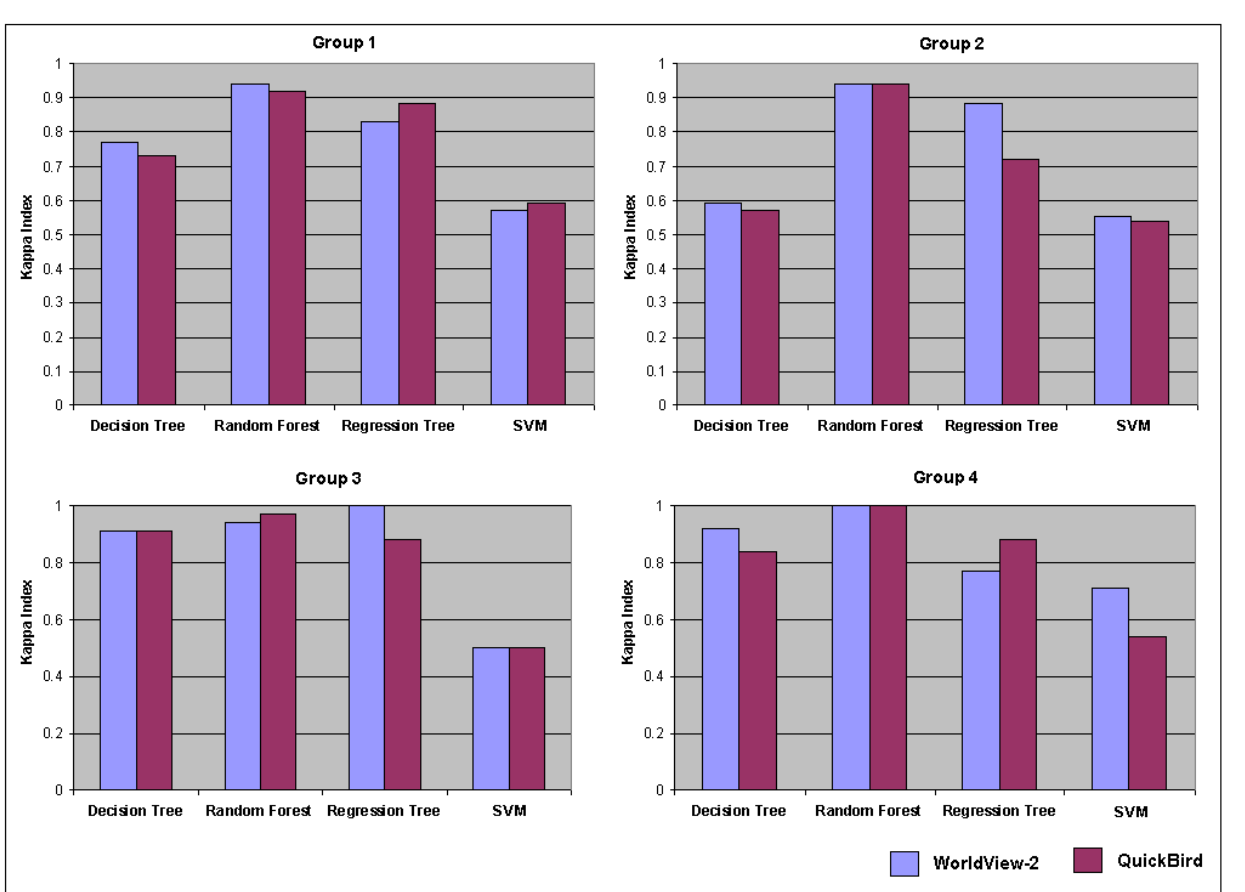
Figure 4. Kappa accuracy index comparison between classifications carried out on each group of classes considering features related to the bands of the WV-2 and QB-2